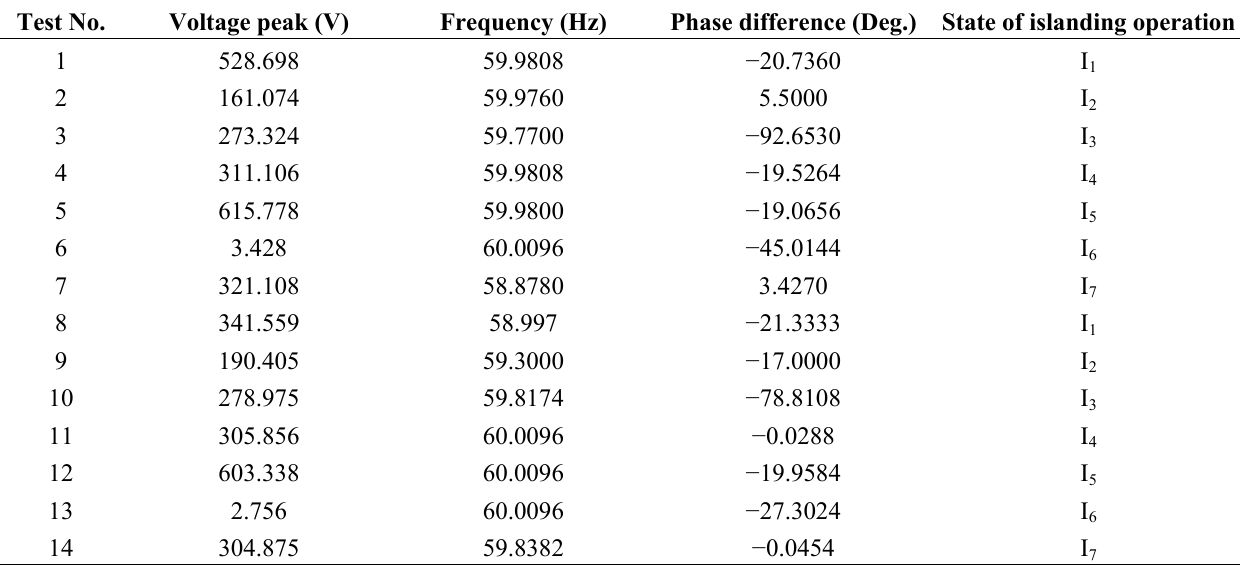
Table 4. Test data for detecting